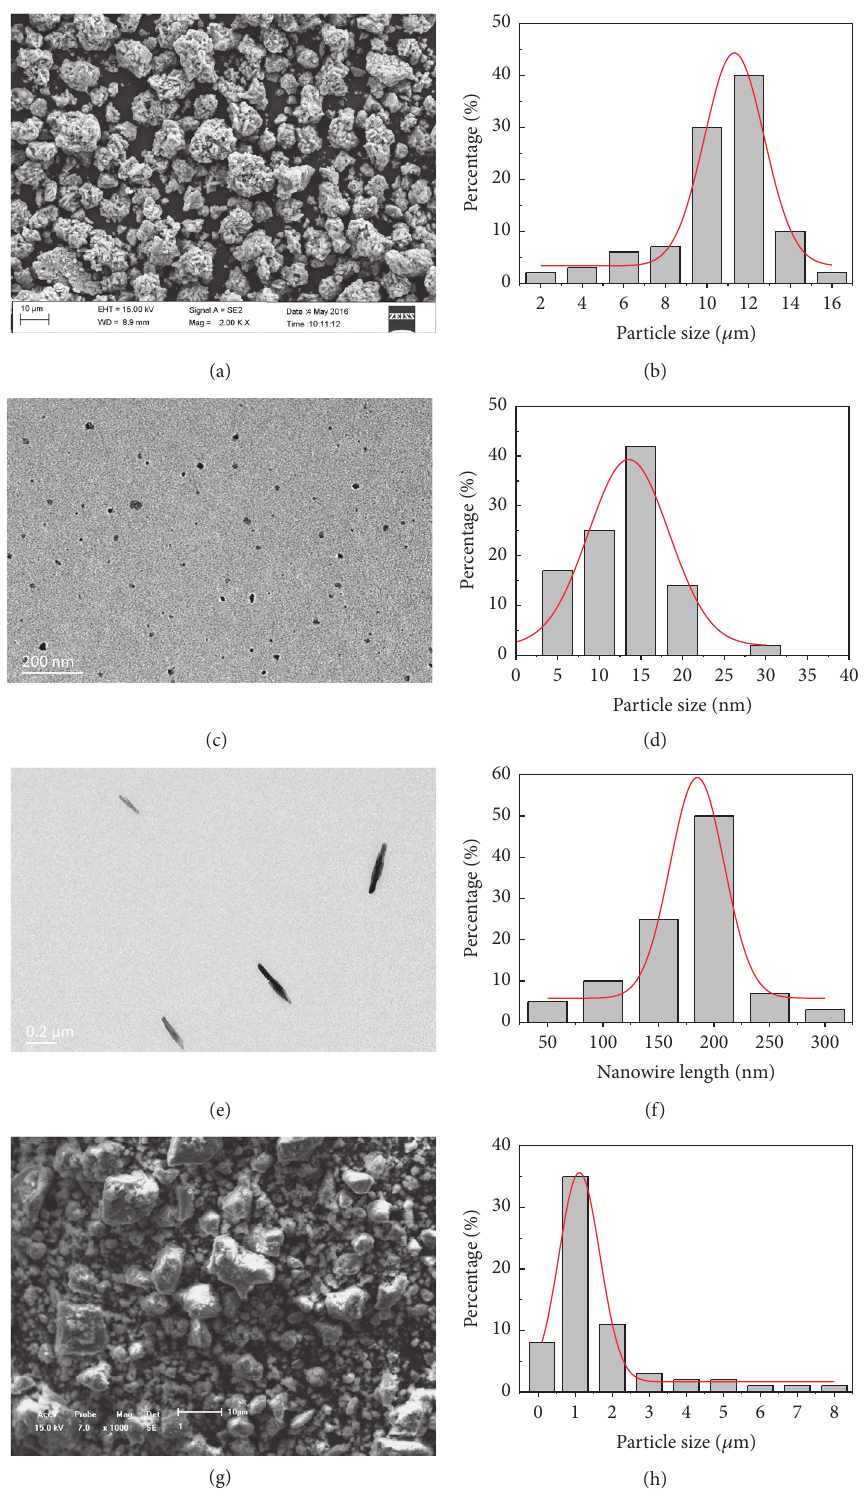
Figure 2: Morphology and particle size distribution of different pyrite samples: (a) and (b) for synthetic pyrite microparticles; (c) and (d) for synthetic pyrite nanoparticles; (e) and (f) for synthetic pyrite nanowires; (g) and (h) for natural pyrite